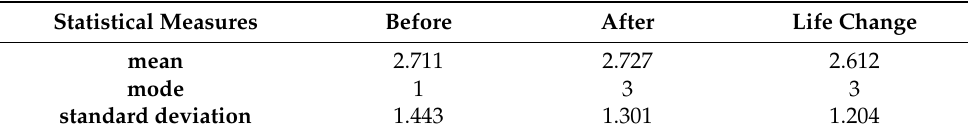
Table 2. Mean, standard deviation, and mode of FINTECH usage calculated using Python via Jupyter Notebook.